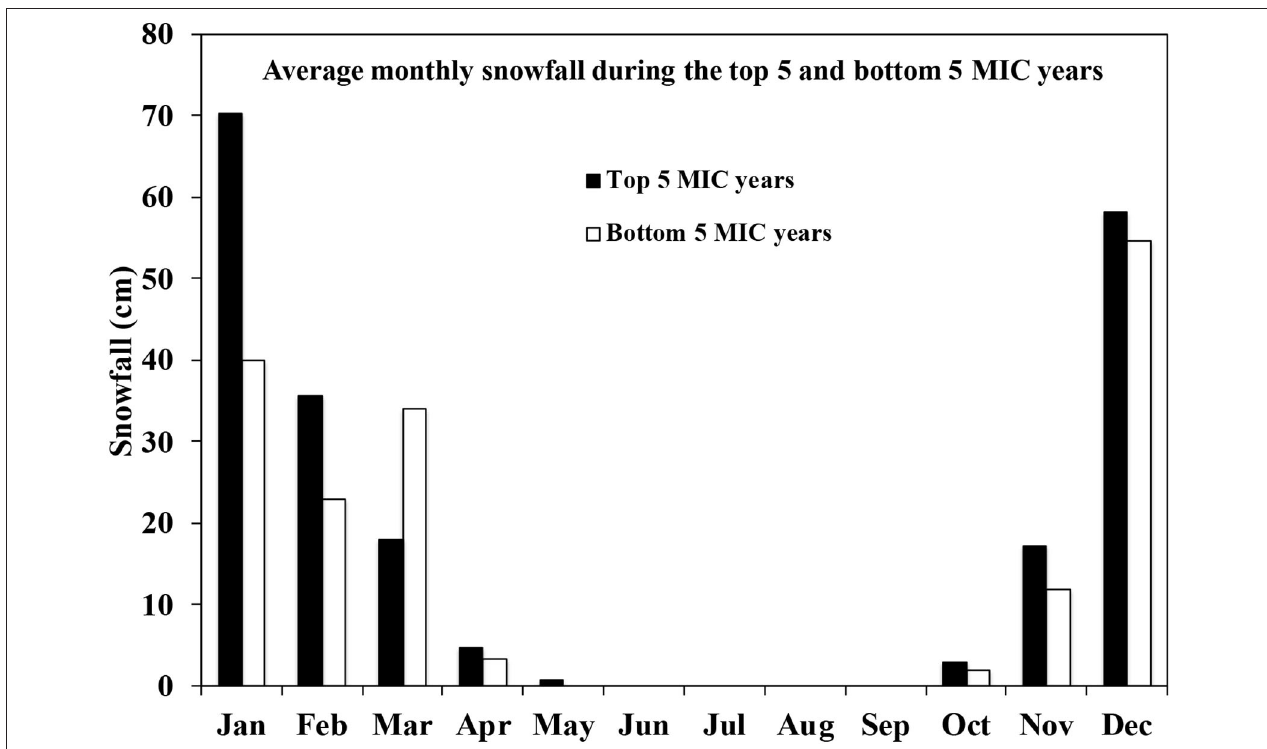
FIGURE 10 | Comparison of snowfall averaged over all eight stations during the top five and bottom five MIC